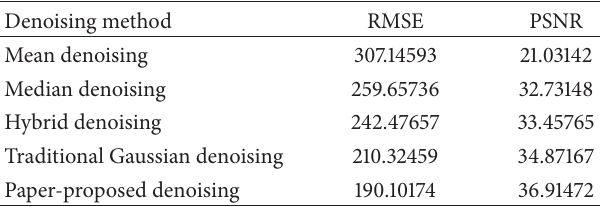
Table 2: Evaluation index of denoising effect of different denoising